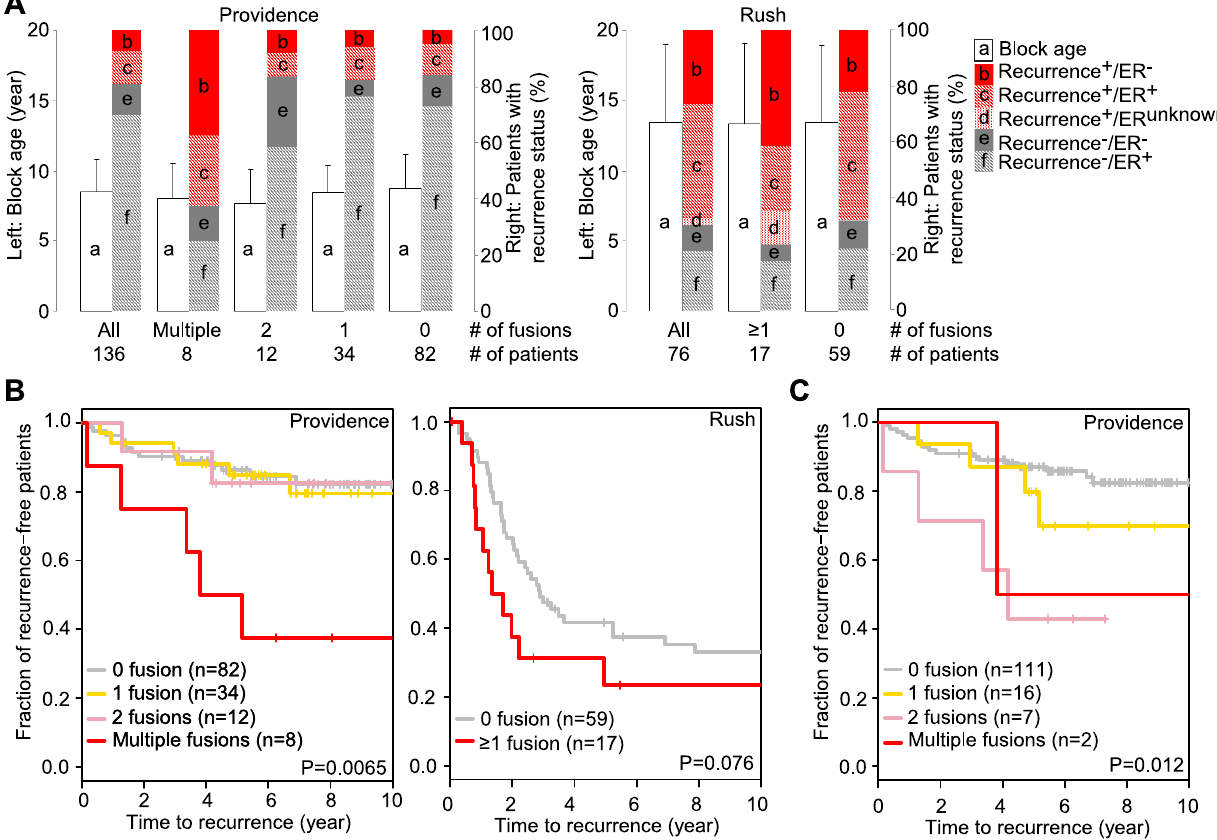
Figure 3. Breast cancers with high fusion frequency have poor prognosis. A. The distributions of block age, clinical recurrence and ER status are shown according to fusion number categories in Providence and Rush cohorts. The archived block age is plotted as mean and standard deviation for each category. ER status was assessed by immunohistochemistry. The patient number for each category is labeled accordingly. B. Kaplan-Meier plots of each fusion number category show Providence patients with multiple fusions had poor prognosis, and a similar trend exists for Rush patients. The log-rank p-values are indicated in Kaplan-Meier plots. C. Kaplan-Meier plot with the 36 TaqMan supported fusion transcripts in the Providence cohort. There are another 11 TaqMan supported fusion transcripts from the Rush cohort but they are too few to generate a meaningful Kaplan-Meier plot.